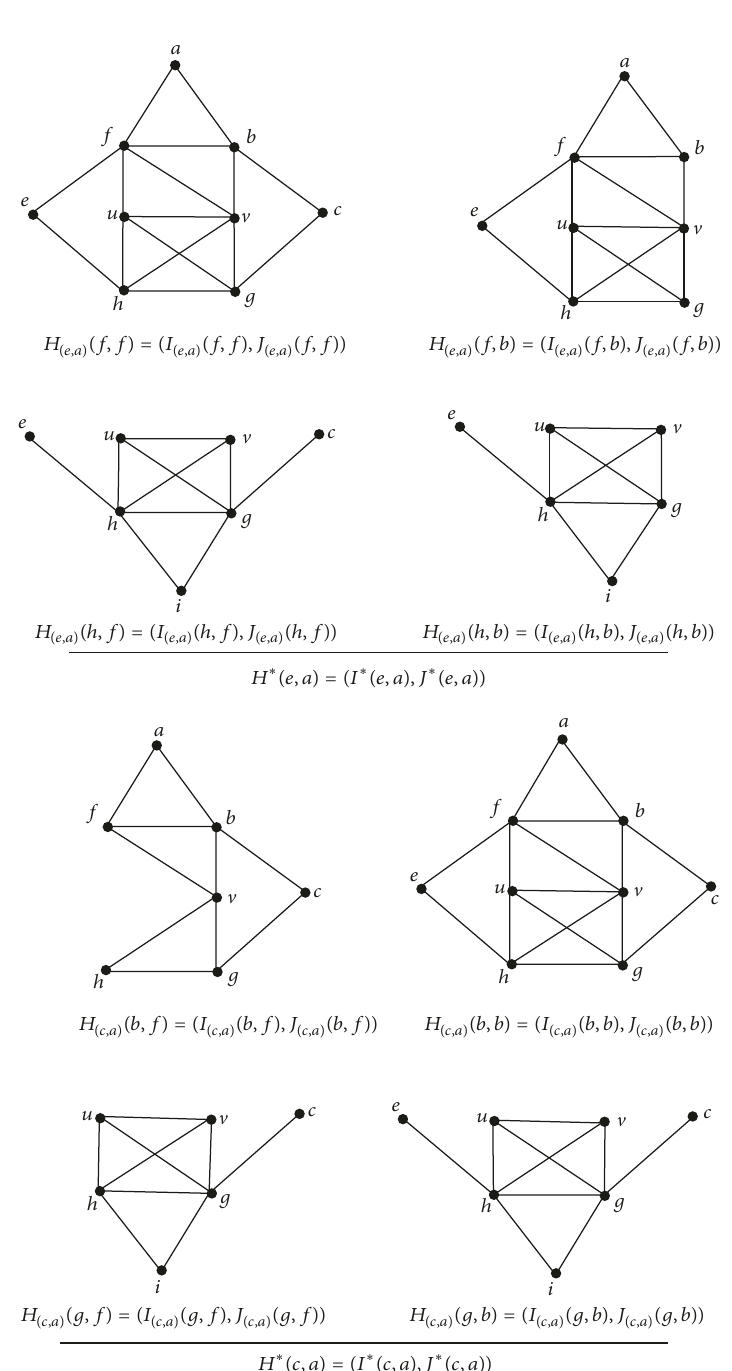
Figure 11: 𝑂𝑅 operations on G ∗ and G ∗󸀠